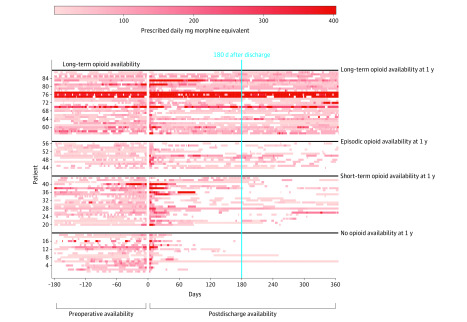
Complete Opioid Prescription Data for Patients With Long-term Preoperative Opioid Availability From 180 Days Through 1 Year PostoperativelyEach row represents a unique patient. Each unique colored box represents a new opioid prescription and its daily morphine milligram equivalents, with darker red representing higher morphine milligram equivalents. Patients are clustered according to their Consortium to Study Opioid Risks and Trends (CONSORT) opioid availability classification at 1 year postoperatively. Two patients classified as having no opioid availability at 1 year had a substantial period during the 180 days after discharge in which opioids were available. These patients did not receive any prescriptions for opioids, but each had a previous prescription for tramadol hydrochloride, which provided prolonged opioid availability extending into this period.